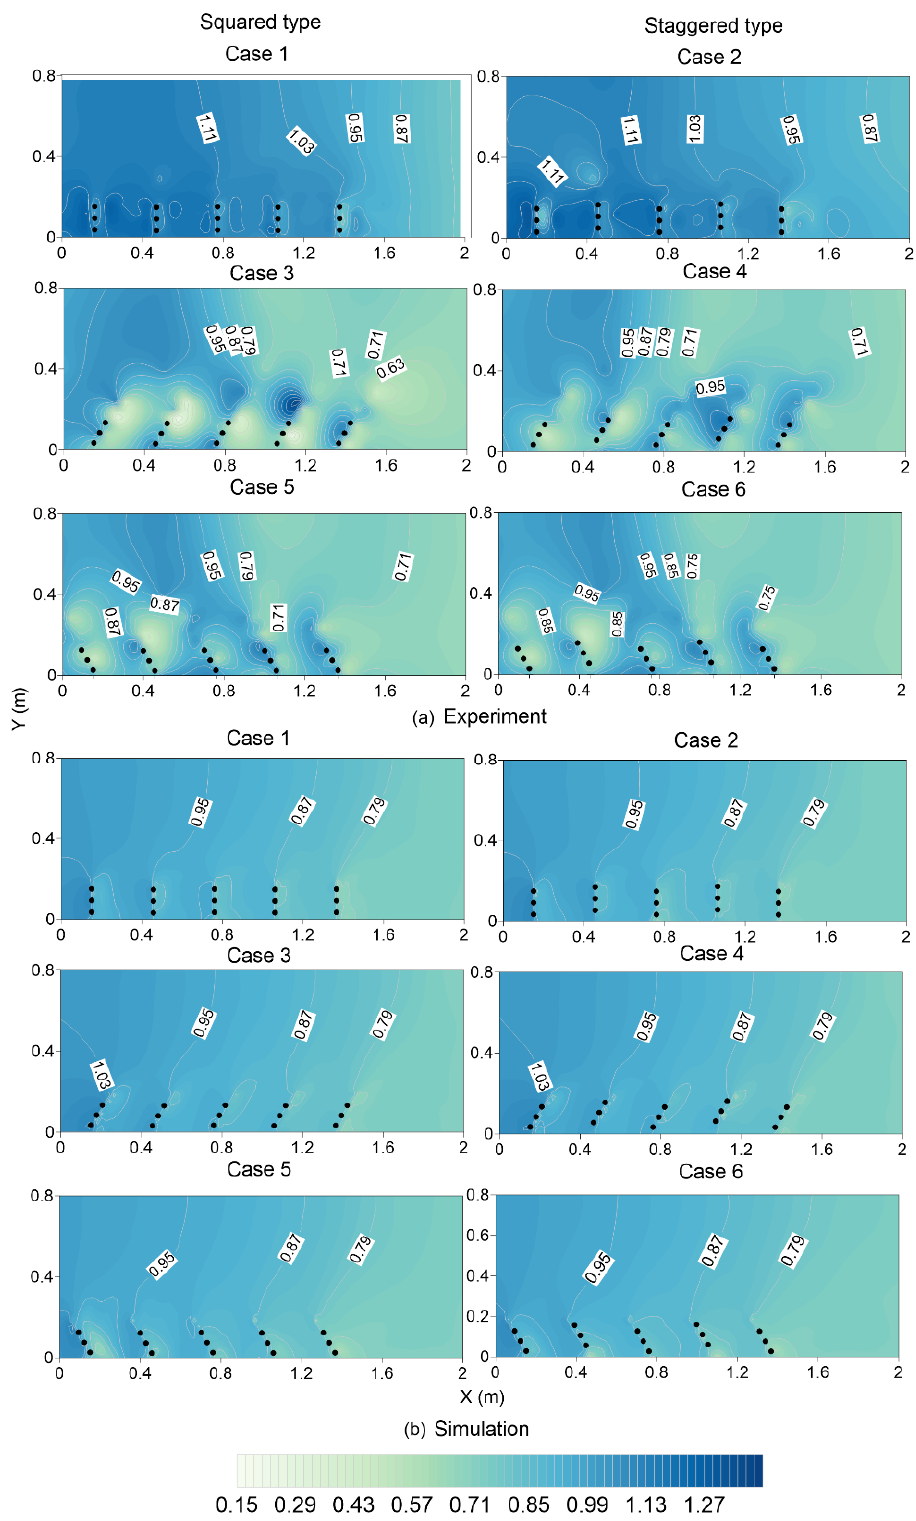
(cid:3048) ) . (cid:3022)